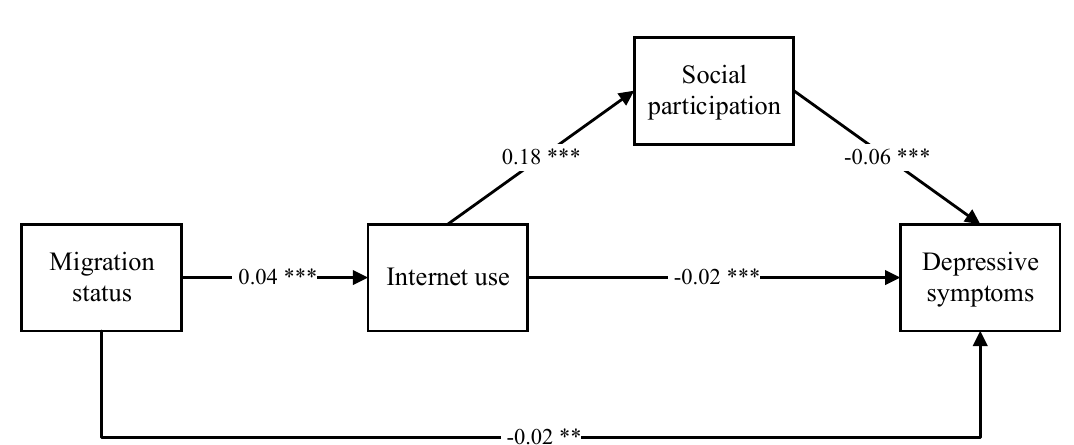
Figure 2. Generalized structural equation model of the effect of migration status, internet use, and social participation to depressive symptoms. Note: * p < 0.05, ** p < 0.01, *** p < 0.001.The model control for age, gender, marital status, education years, retired or not, household per capita consumption expenditure in the previous year (RMB), living with children or not, Hukou, and wave, Log Likelihood (LL) = − 161,245.9, Degree of Freedom (DF) = 23, Akaike Information Criterion (AIC) = 322,537.8, Bayesian Information Criterion (BIC) = 322,736.